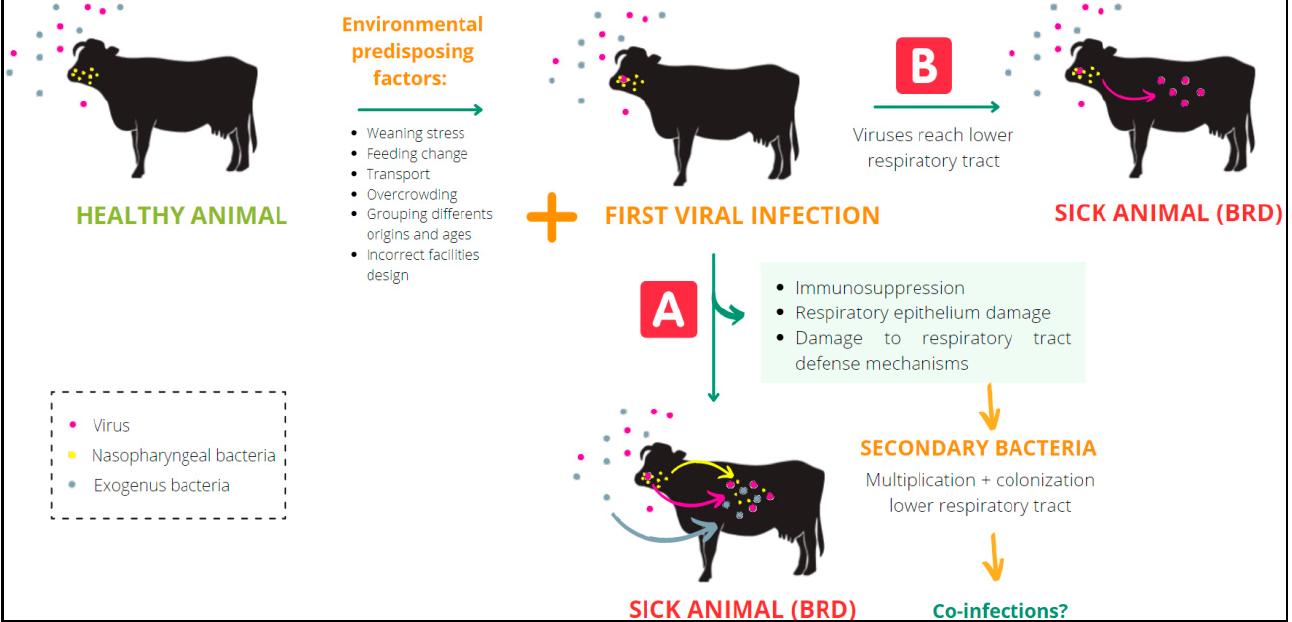
Figure 1. Mechanism of viruses predisposing the infection of bacteria in BRD.